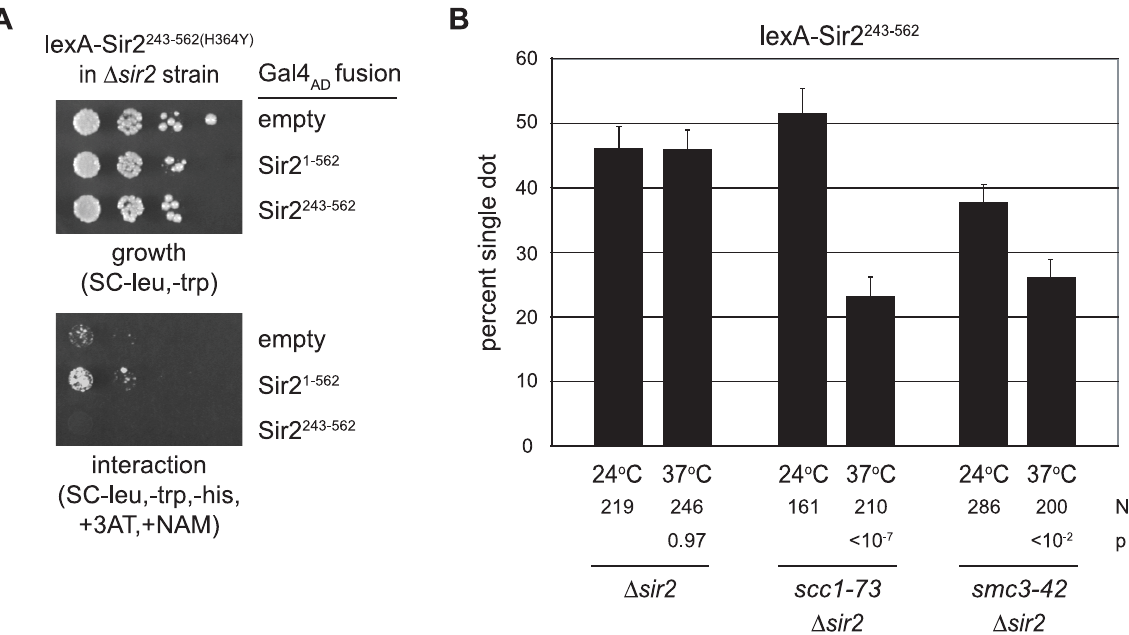
Figure 5. Cohesion by Sir2 requires the cohesin genes. A ) Two-hybrid assay for Sir2 self-association. Strain JCY13 ( LYS2::(4xlex op )-HIS3 D sir2 ) expressing lexA-Sir2 243–562(H364Y) (pCSW55) in combination with Gal4 AD (pGAD-C1), Gal4 AD -Sir2 1–562 (pCTC85), or Gal4 AD -Sir2 243–562 (pCSW58) was plated in serial dilution on SC-trp,-leu to monitor growth and SC-trp,-leu,-his supplemented with 5 mM 3-aminotriazole (3AT) and 5 mM nicotinamide (NAM) to monitor interactions. 3-AT raises the level of HIS3 expression necessary for growth. NAM was included in case recruitment of functional Sir2 caused silencing of the reporter gene. B ) Targeted cohesion assay in cohesin mutants. Cultures were pre-grown at 24 u C according to the standard protocol (Materials and Methods). Two hours after the addition of galactose and benomyl, half of each culture was shifted to 37 u C while the other half was maintained at 24 u C. Two hours later, the cells were harvested and fixed. Strains CSW42 ( D sir2 ), CSW75 ( scc1-73 D sir2 ) and CSW152 ( smc3-42 D sir2 ) expressed lexA-Sir2 243–562 (pCSW1). P values report the significance of the temperature shift on cohesion for each strain